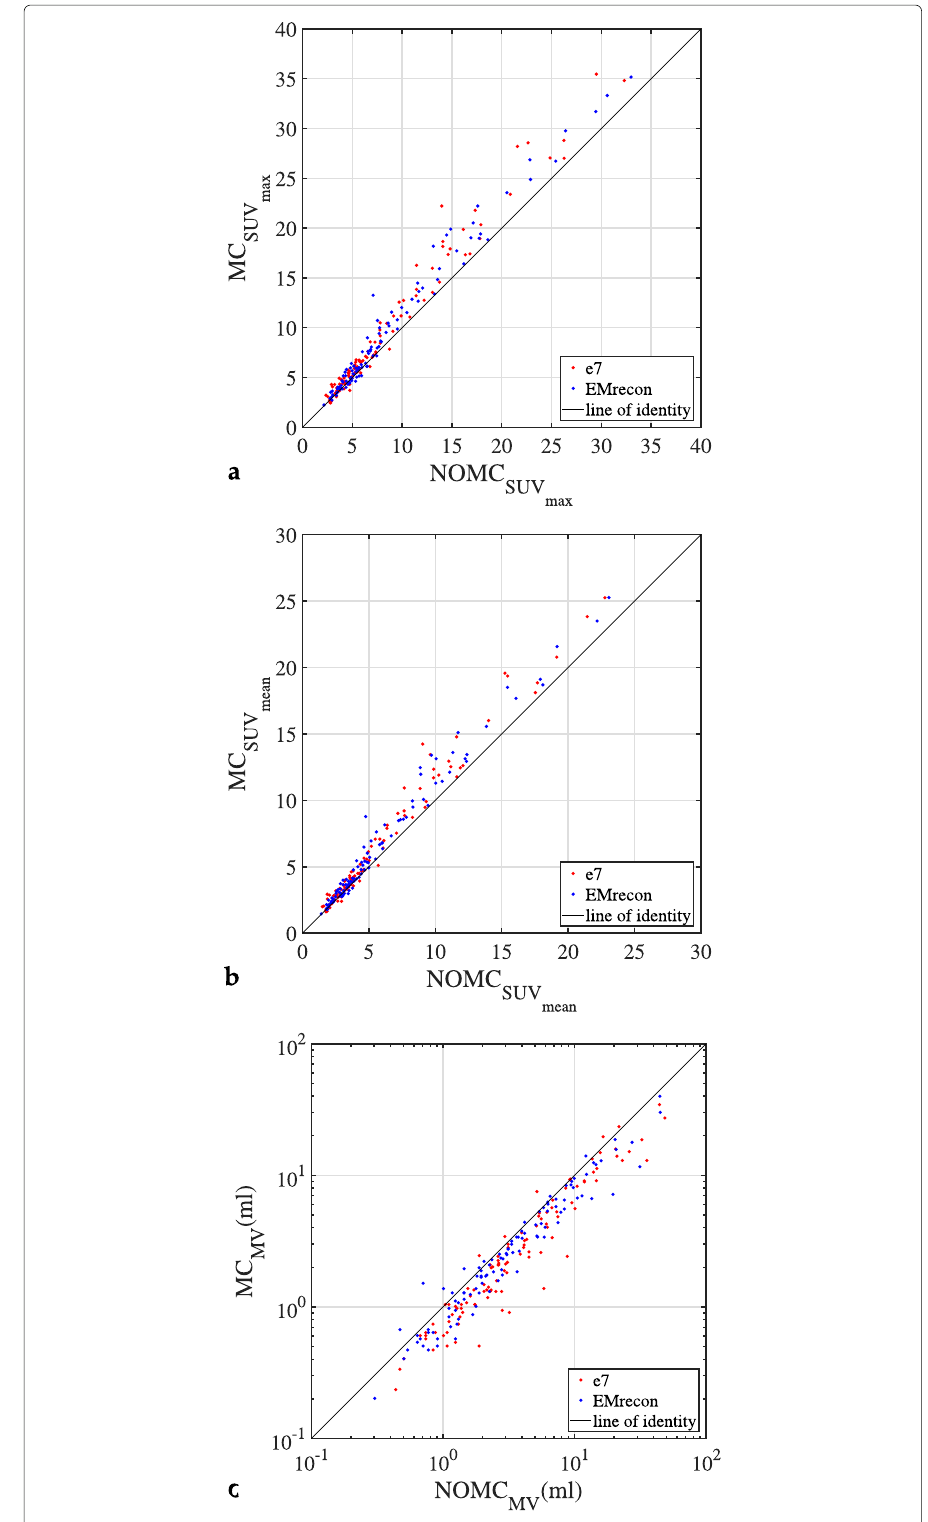
Fig. 9 Scatter plots for a SUV max , b SUV mean , and c MV comparing e7 and EMrecon reconstructions before and after